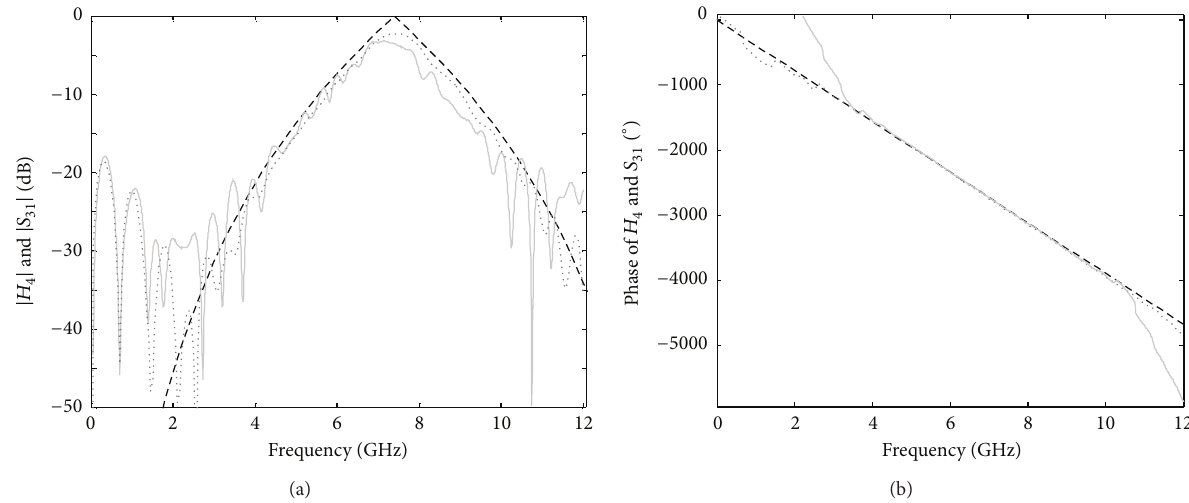
Figure 17: Target (black dashed line), simulated (dark grey dotted line), and measured (light grey solid line) magnitude (a) and phase (b) of the frequency response of the 4th-order differentiator.